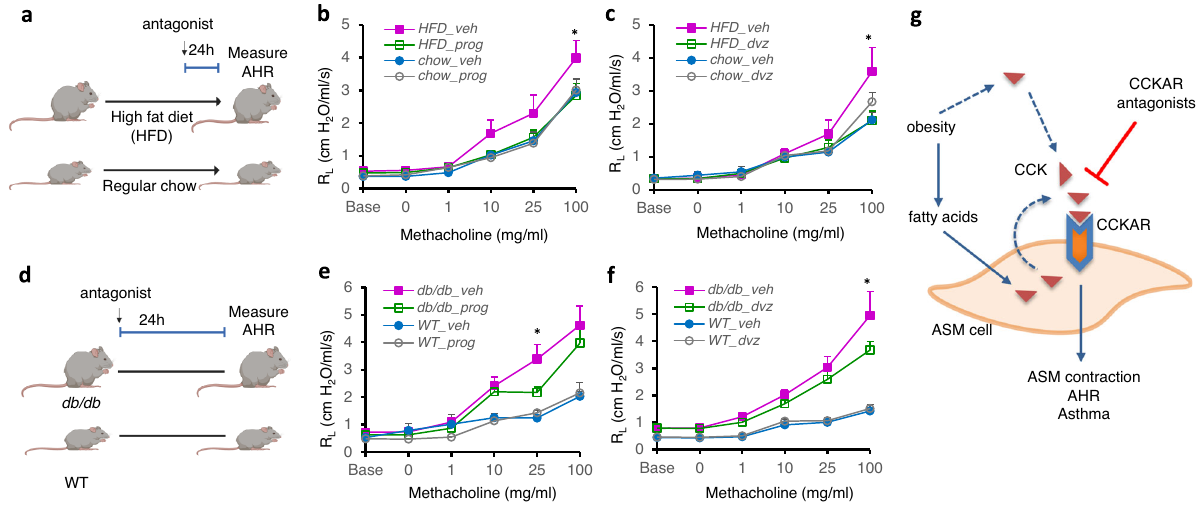
Fig. 4 | CCK contributes to innate AHR in mouse models of obesity-associated AHR. a Scheme of CCKAR antagonist treatment in HFD or regular chow-fed mice. Eight-week old C57BL/J6 mice were fed with HFD or regular chow for at least 13 weeks. Mice were then given proglumide (50mg/kg) or devazepide (25 μ g/kg) intranasallyandAHRwasassessedbyFlexivent. b PulmonaryresistanceinHFD-fed mice treated with proglumide (HFD_prog, n =11) or vehicle (HFD_veh, n =12) and regularchow-fed mice treated with proglumide (chow_veh, n =8) or vehicle (chow veh, n =9). * P =0.0070 (HFD_prog vs. HFD_veh); F values: treatment ( F =5.664, P =0.0009); methacholine ( F =63.60, P <0.0001); interaction ( F =0.7942, P =0.6835). c Pulmonary resistance in HFD-fed mice treated with devazepide (HFD_dvz, n =9)orvehicle(HFD_veh, n =9)andregularchow-fedmicetreatedwith devazepide(chow_dvz, n =5)orvehicle(chow_veh, n =6).* P <0.0001(HFD_dvzvs. HFD_veh); F values: treatment ( F =2.934, P =0.0354); methacholine ( F =50.13, P <0.0001); interaction ( F =1.645, P =0.0684). d Scheme of CCKAR antagonist treatmentin db/db orWTcontrolmice.Miceweregivenproglumide (50mg/kg)or devazepide(25 μ g/kg)intranasallyandAHRwasassessedbyFlexivent. e Pulmonary